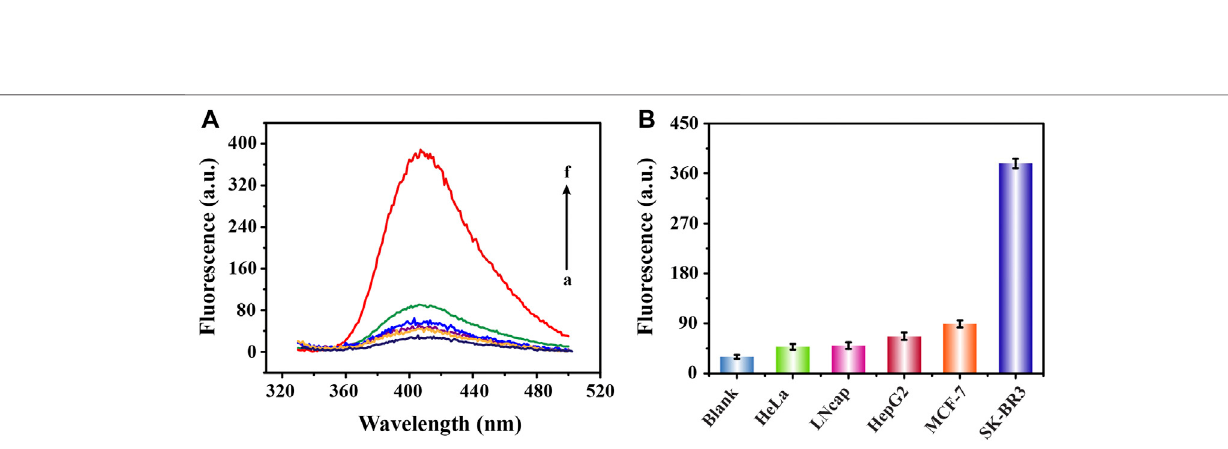
FIGURE4| Sensitivity analysisof fl uorescencedetection ofexosomes atdifferentconcentrations.Thecorresponding fl uorescenceemission spectra (A) and linear fi ttings (B) obtained by detecting a series of different concentrations of exosomes (0, 2.5, 5, 10, 25, 50, 100 particles/mL e+5, from a to g).